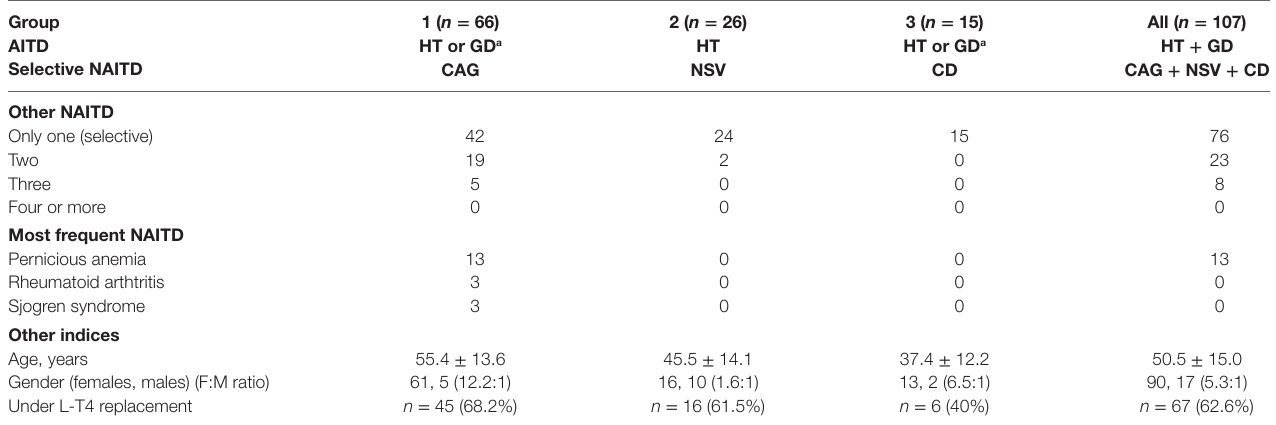
TaBle 1 | Demographics of patients and controls according to AITD and NTAID. group